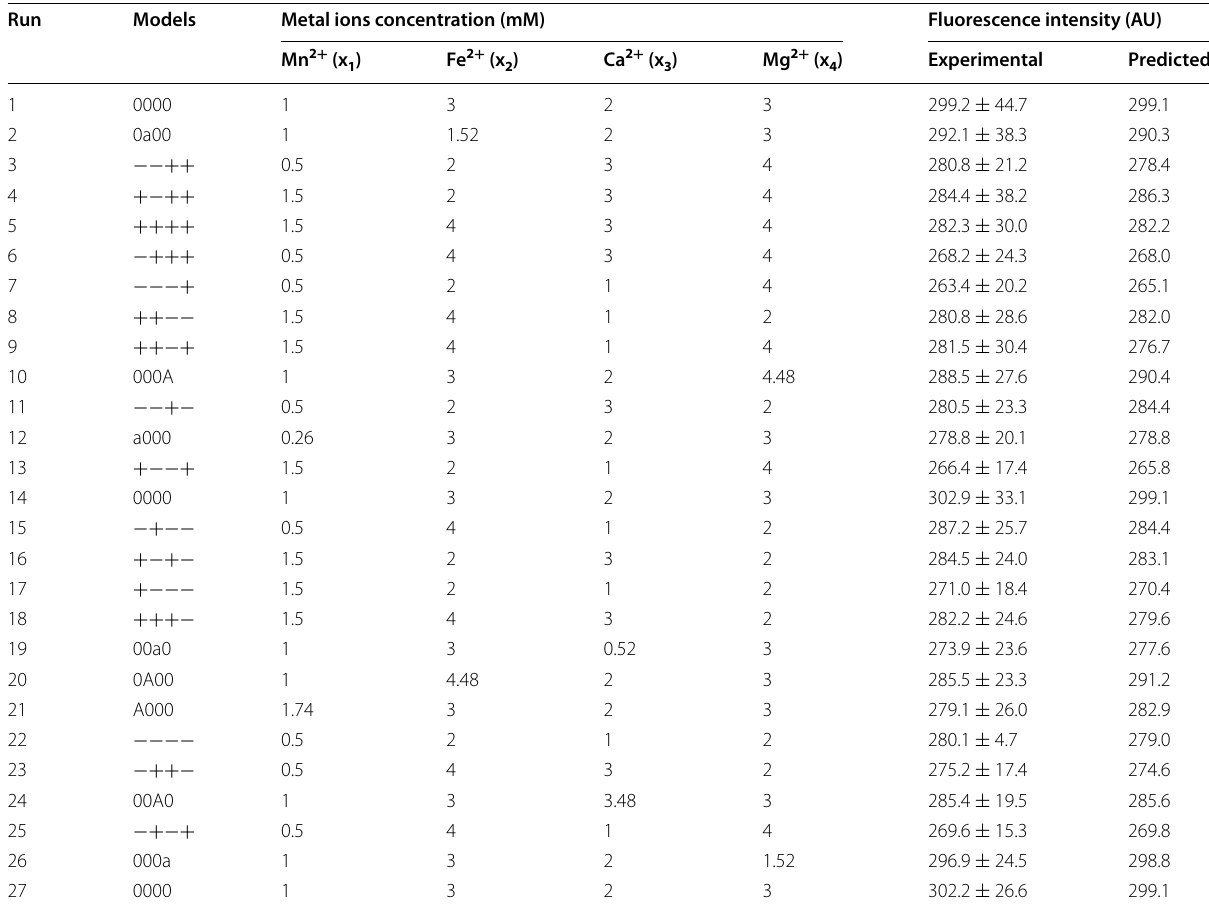
Table 2 Central composite design for metal ion factors associated with spore density by the fluorometric assay